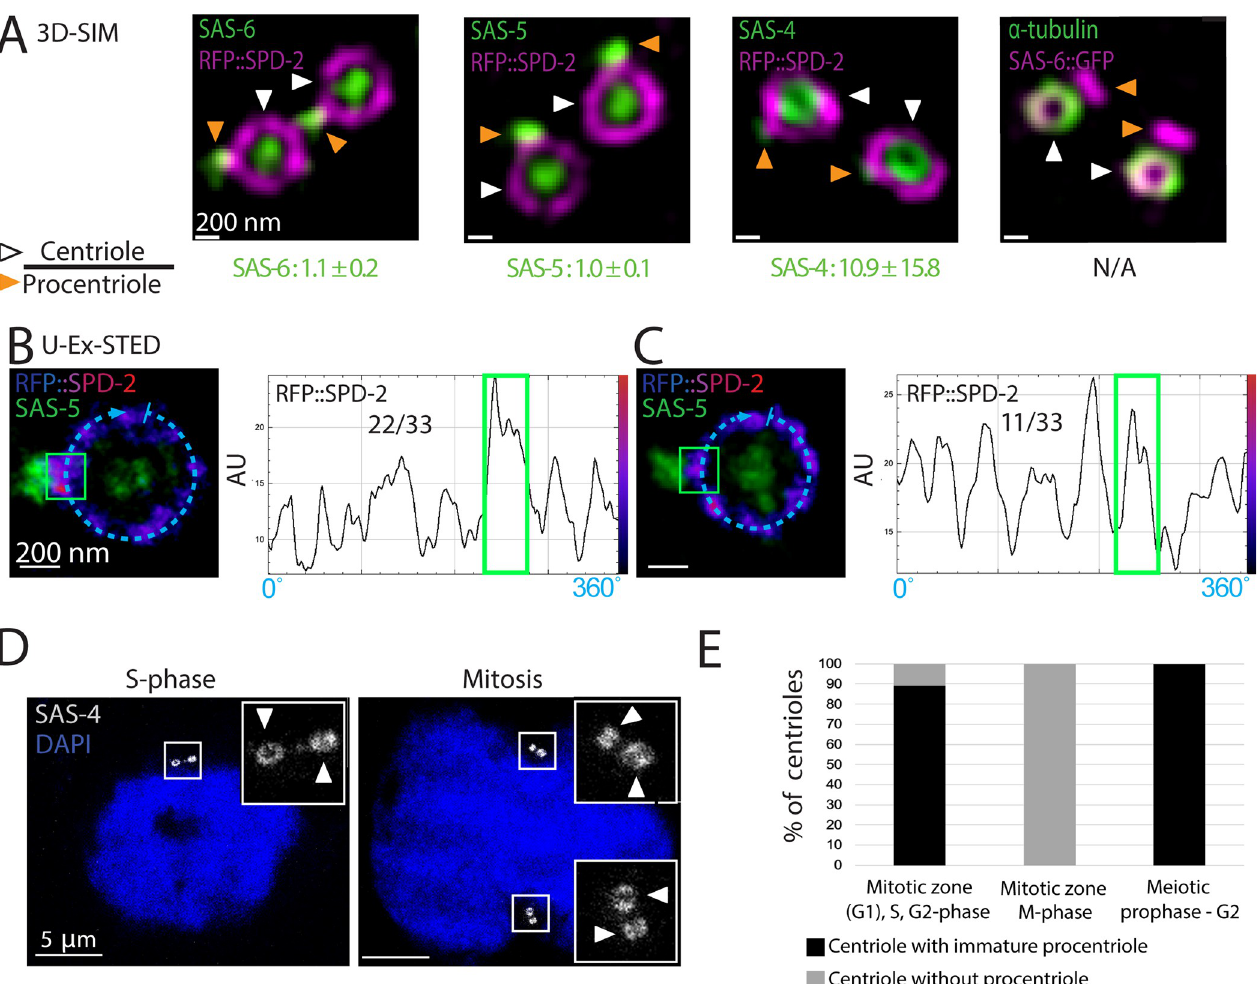
Fig 2. Composition and maturation of the procentriole. (A) 3D-SIM sum intensity Z-projected images of expanded centrioles from early meiotic prophase stained for the indicated proteins. White arrowheads point to centrioles, orange arrowheads to procentrioles. The presence of a ring-like distribution of RFP:: SPD-2 (magenta) around one of the 2 green foci (SAS-6, SAS-5, or SAS-4) served to identify the centriole. The numbers below the images represent the ratio between the fluorescence of the indicated component in the centriole versus the procentriole ( N = SAS-6: 8, SAS-5: 17, SAS-4: 18; ± indicates SD). Here and in all other figures, scale bars within a series represent the same length (e.g., 200 nm in this case). (B, C) (Left) U-Ex-STED of centrioles from early meiotic prophase revealing RFP::SPD-2 and SAS-5 distribution. RFP::SPD-2 signals are displayed with the LUT “Fire” (low intensities in blue, high intensities in magenta and red). (Right) Corresponding signal intensity profiles along the dashed line depicted in the image (10 pixels wide). The green boxes in the images and the graphs indicate RFP::SPD-2 located under the procentriole identified by SAS-5. In the majority of cases, the RFP::SPD-2 signal is wider and brighter below the procentriole than anywhere else in the centriole (B, 22/33), whereas such enrichment could not be detected in the remainder cases (C, 11/33). (D) U-Ex-STED of nuclei in either S-phase (left) or mitosis (right) from the mitotic zone of the gonad. White arrowheads point to centrioles fully decorated with SAS-4 (mature centrioles). SAS-4 signal intensity between the pair of centrioles present on each pole of the mitotic spindle varies by merely 14 ± 9% SD, N = 12 pairs. (E) Percentage of centrioles (identified by SAS-6 surrounded by SPD-2) with or without a neighboring immature procentriole (identified by SAS-6 not surrounded by SPD-2) during the indicated stages. Nuclei in mitosis were identified by DNA staining as having the most condensed chromatin in the miotic region of the gonad; N = Mitotic zone (G1), S, G2-phase: 37, Mitosis (mitotic zone): 7, early meiotic prophase: 46. Data underlying the graphs shown in the figure can be found in S1 Data. SD, standard deviation; SIM, Structured Illumination Microscopy; U-Ex-STED, Ultrastructure Expansion coupled with STimulated Emission